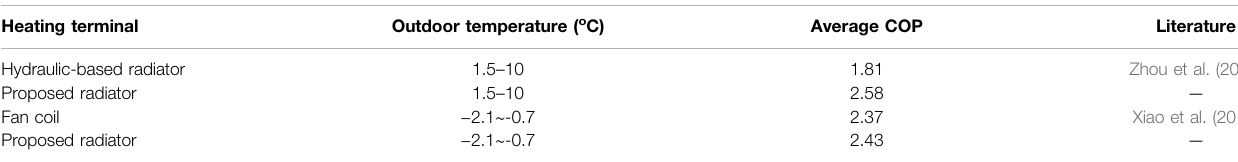
TABLE 3 | Comparison of COP for different systems.